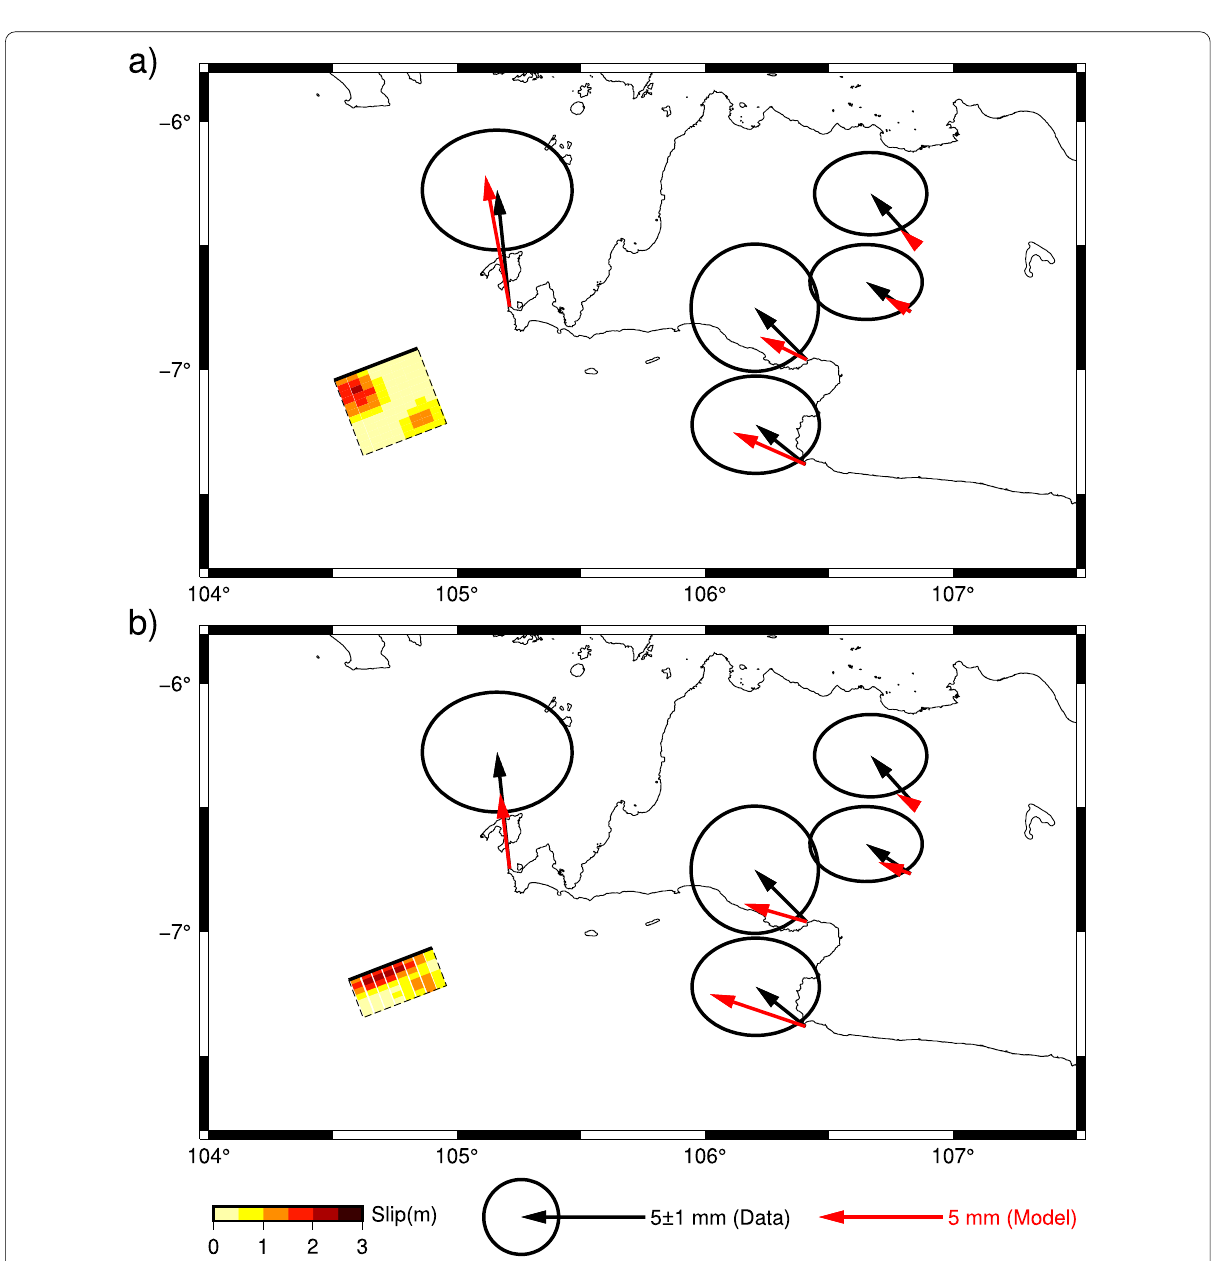
Fig. 2 Coseismic slip inversion results for a Model 1A; b Model 1B. The black vectors indicate the GNSS data used in the inversion, while the red vectors show the displacement models. The solid black line delineates the top of the